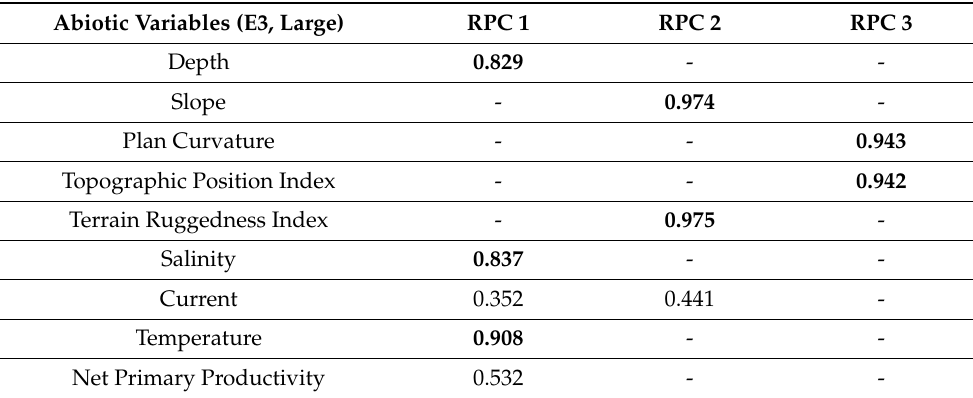
Table 4. Rotated components matrix. Correlation between the original input variables and the Varimax rotated principal components for the larger study area using three eigenvalues. Values with r > 0.7 or r < − 0.7, are considered high factor loads (bold), while low factor loads (r < 0.3 or r > − 0.3) are